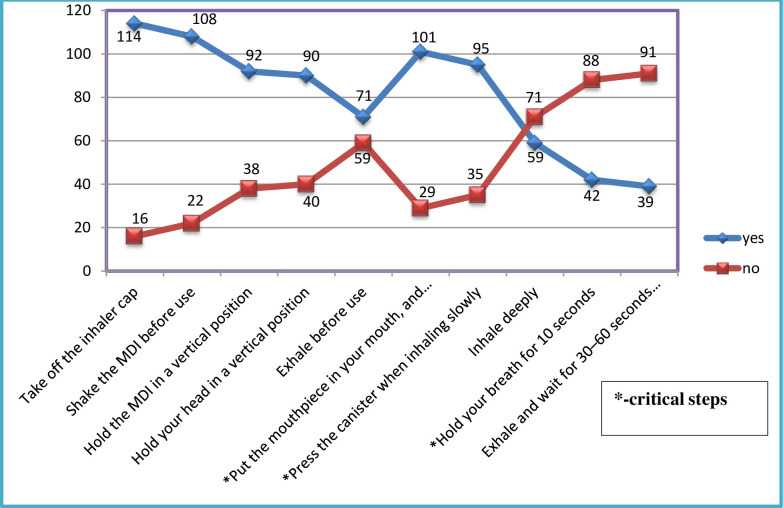
Instructions measurements for MDI (step-wise correct use of the inhalation techniques) at JMC, April-September, 2019.*MDI-metered dose inhalations.